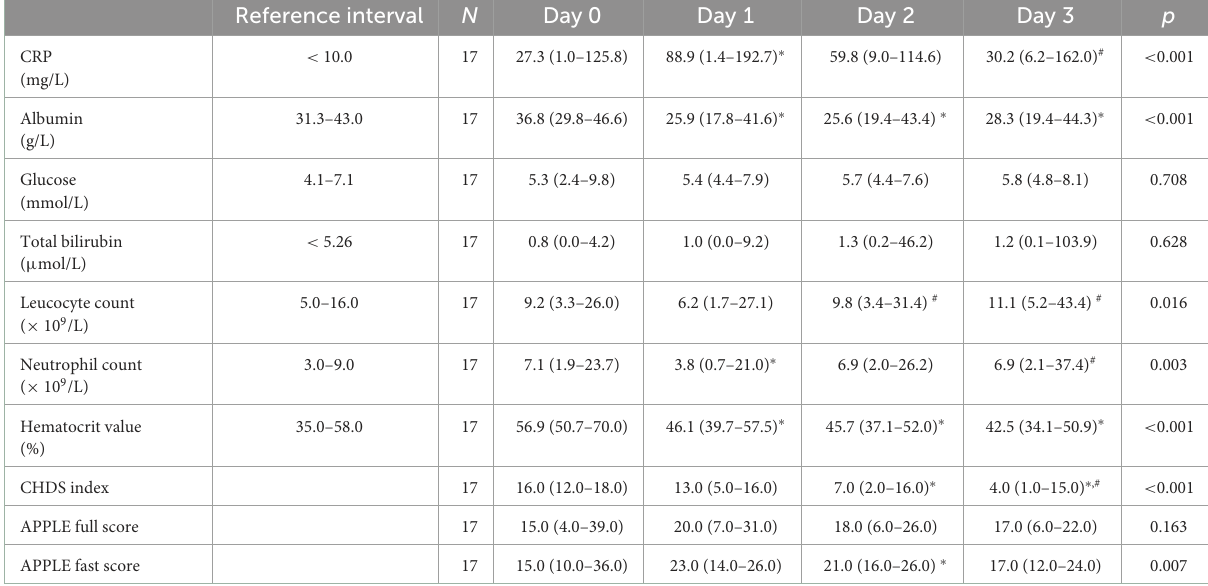
TABLE 1 Laboratory variables, and clinical scores of 17 dogs with acute hemorrhagic diarrhea syndrome (ADHS) evaluated upon admission and during the course of the disease.